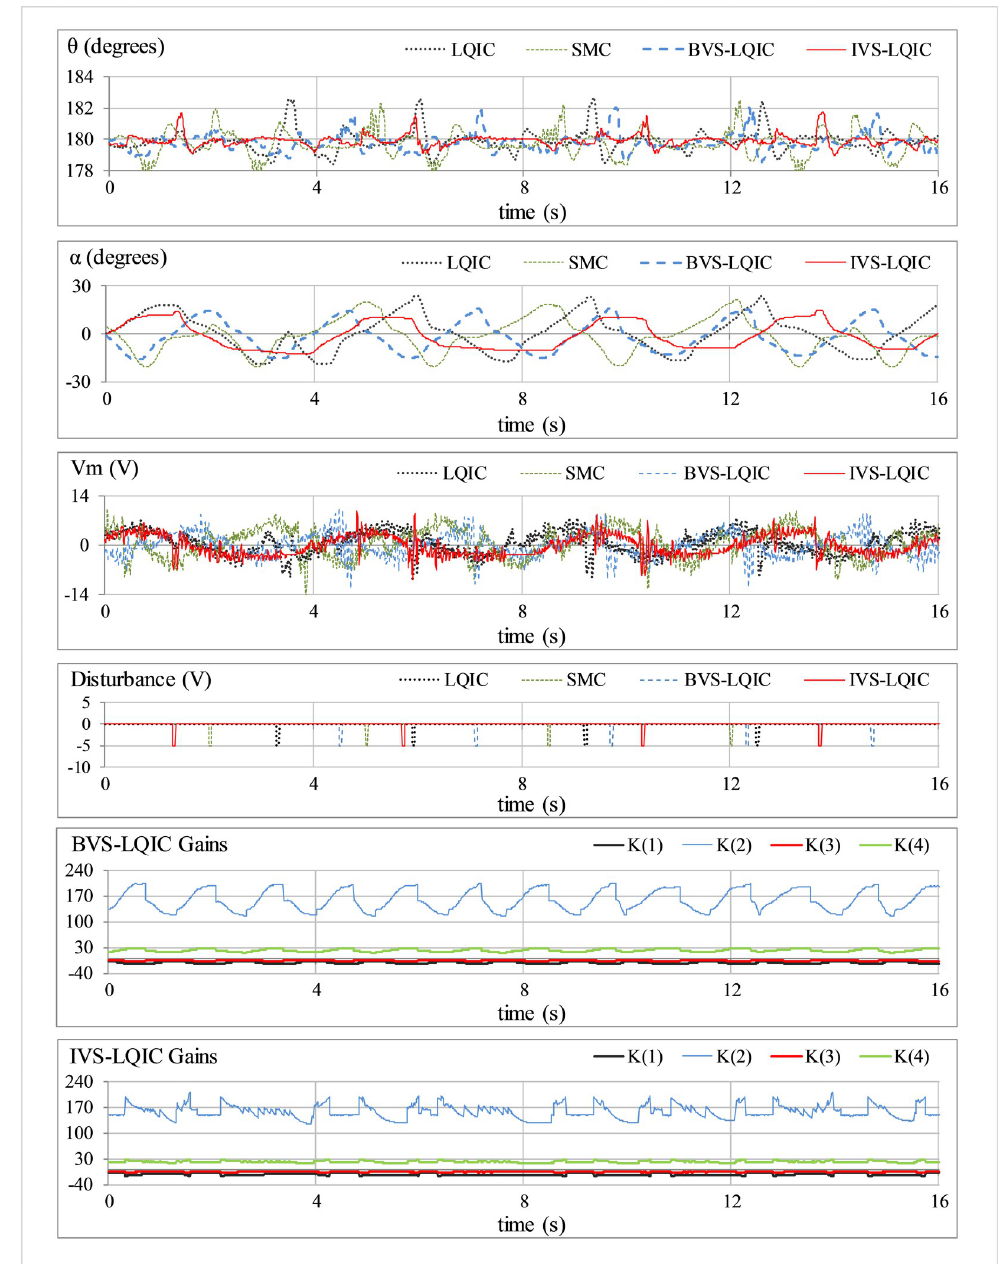
Fig 8. Pendulum’s response under impulsive